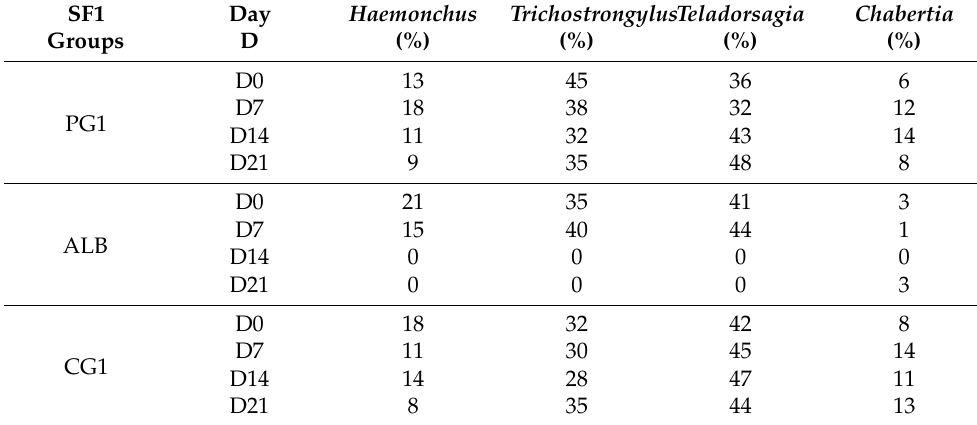
Table 3. Percentage of sheep nematode third-stage larvae (L3) for each group at D0, D7, D14 and D21 in sheep farm 1 (SF1); PG1 treated aqueous P. granatum macerate group 1 (50/mL/OS as a single dose); ALB treated Albendazole group (3.75 mg/Kg/BW/OS as a single dose); CG1 untreated control group 1.